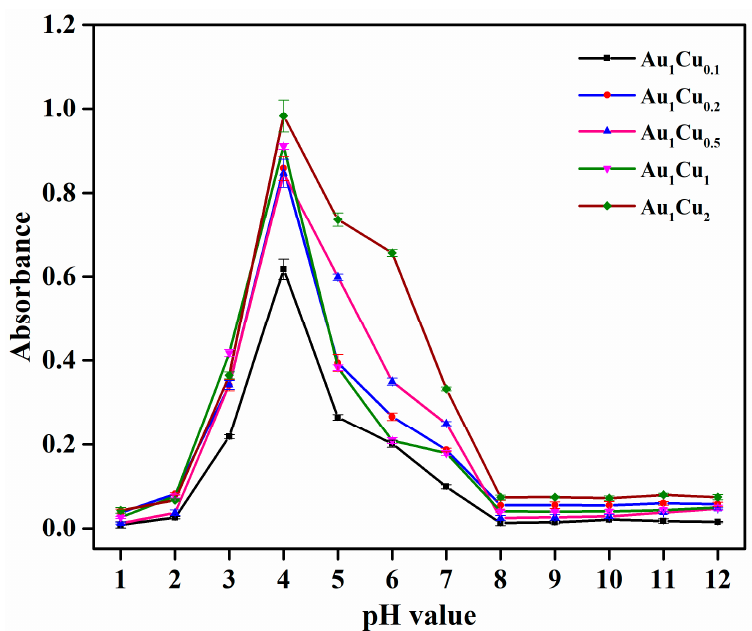
Figure 2. The pH-dependent response curve for H 2 O 2 detection using the as-prepared Au–Cu alloy nanoparticles incubated at room temperature. The error bars represent the standard deviation of three measurements.